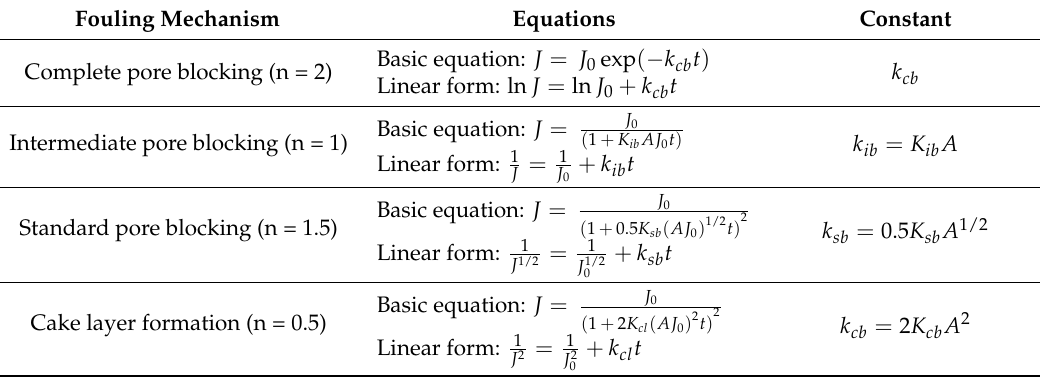
Table 2. Equations in Hermia’s model equations for four type of fouling mechanisms. Fouling Mechanism